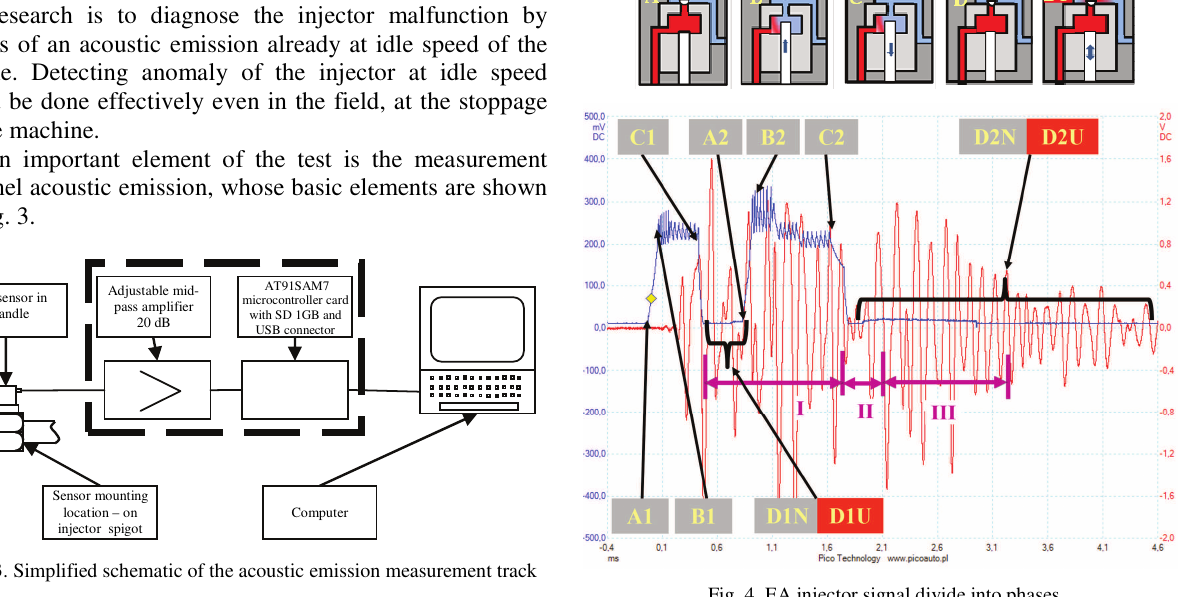
Fig. 4. EA injector signal divide into